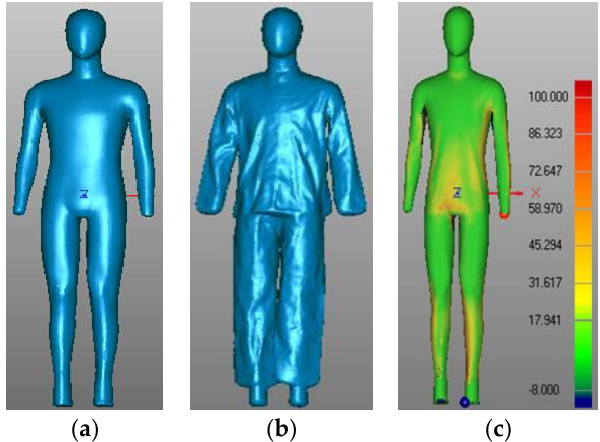
Figure 1. Determination of the air gap distribution: ( a ) scanned nude mannequin; ( b ) scanned clothed mannequin, and ( c ) air gap distribution.